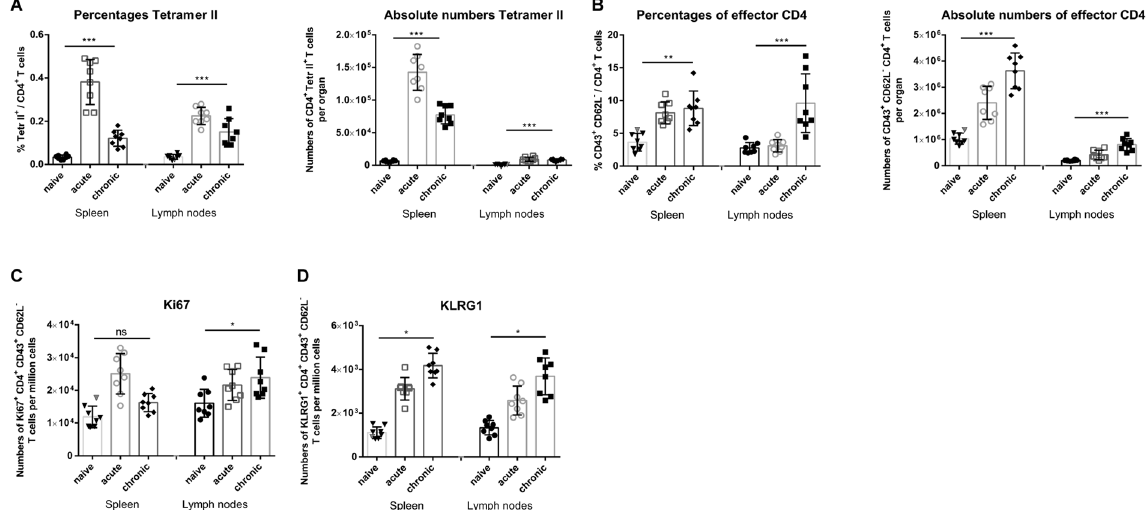
Figure 2. CD4 + T cell response during chronic FV infection. C57BL/6 mice were chronically infected with FV (6 weeks post infection). ( A ) Percentages and absolute numbers of CD4 + Tetr II + T cells reactive with I-Ab MHC class II tetramers specific for the FV H19-Env epitope. ( B ) Percentages and absolute numbers of CD4 + T cells showing the activation profile CD43 + and CD62L − . ( C ) Numbers per million cells of effector CD4 + T cells expressing proliferation marker Ki67. ( D ) Numbers per million cells of effector CD4 + T cells expressing the differentiation marker KLRG1. Each dot represents an individual mouse. Mean values are indicated by a line. Statistically significant differences between the groups were determined by the unpaired t test: * p < 0.05; ** p < 0.005; *** p < 0.0001, ns, not significant. Data were pooled from two independent